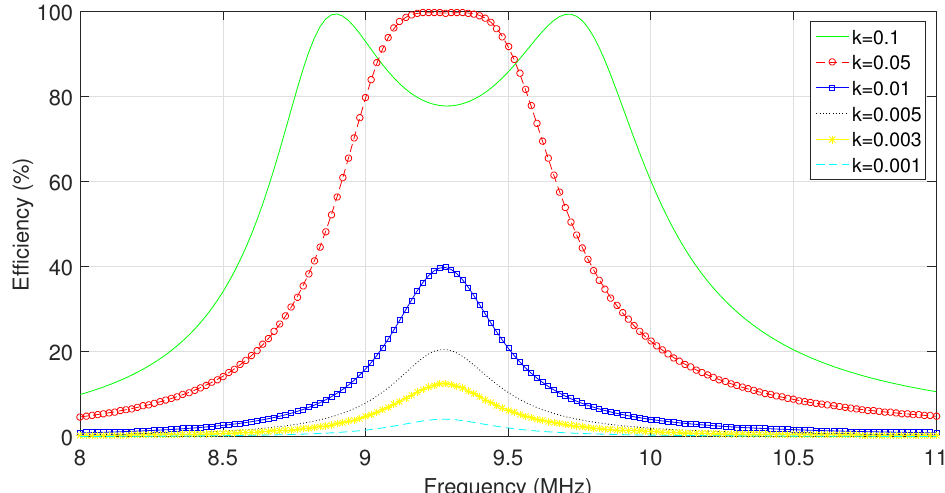
Figure 5. Efficiency of the system with low Q factor of the coil without additional inductor, calculated with advanced design system (ADS) software. A coupling factor at which maximum efficiency appears is much higher than that for the system with high Q.